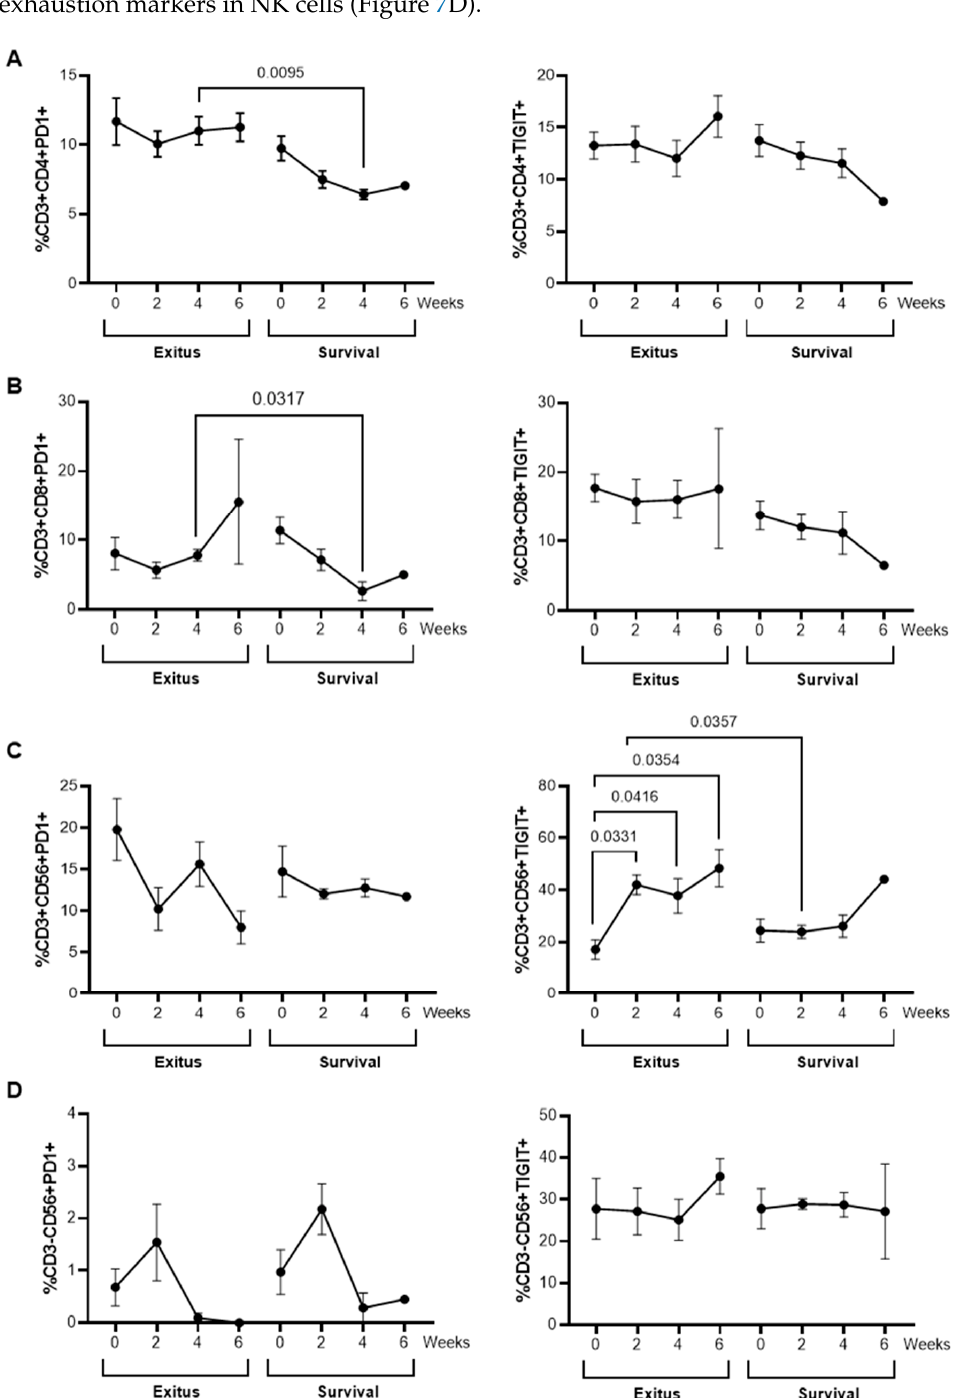
Figure 7. Expression levels of exhaustion markers in PBMCs from individuals hospitalized with critical COVID-19. Expression levels of PD-1 and TIGIT in CD4+ T cells ( A ), CD8+ T cells ( B ), NKT cells ( C ), and NK cells ( D ). Each dot corresponds to the mean of data, and vertical lines represent SEM. Statistical significance between groups was calculated using Mann–Whitney U-test, and within groups, ANOVA was used.